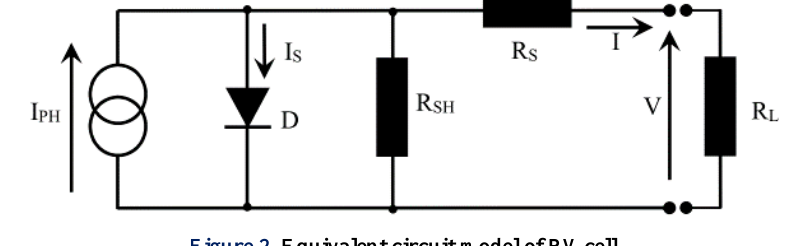
Figure 2. Equivalent circuit model of PV